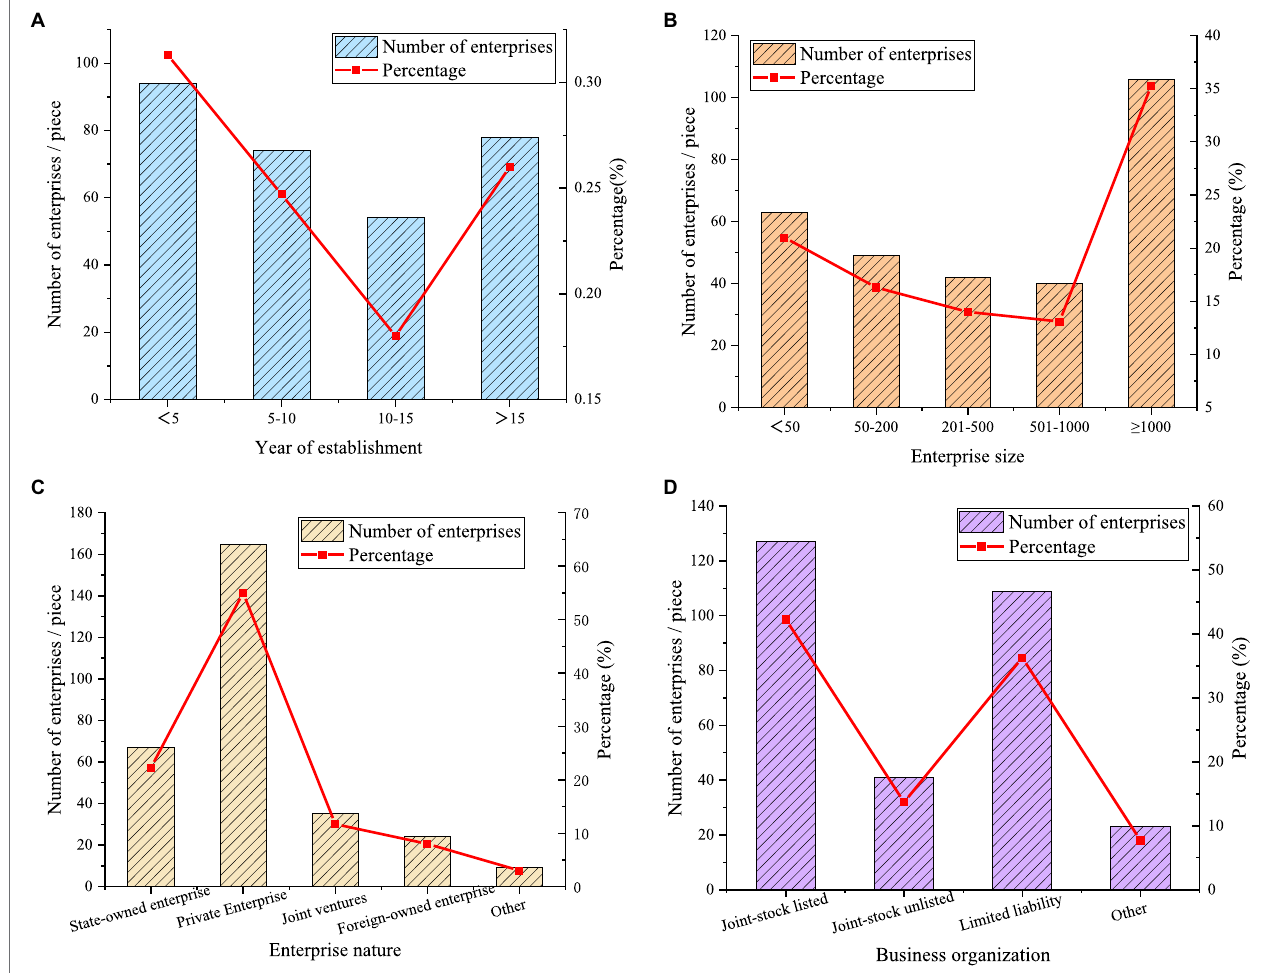
FIGURE 7 | Basic characteristics of the sample. (A) Years of the establishment of the enterprise; (B) Enterprise scale; (C) Enterprise nature; and (D) Enterprise organizational